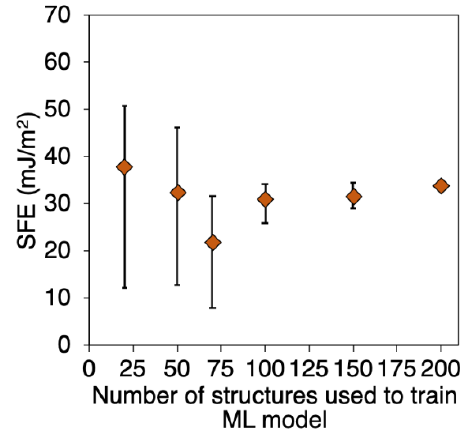
Figure 10. Correlation between the number of 480-atom supercells used to train the model and the variation in the ML-predicted SFE. Diamonds show the average SFE.